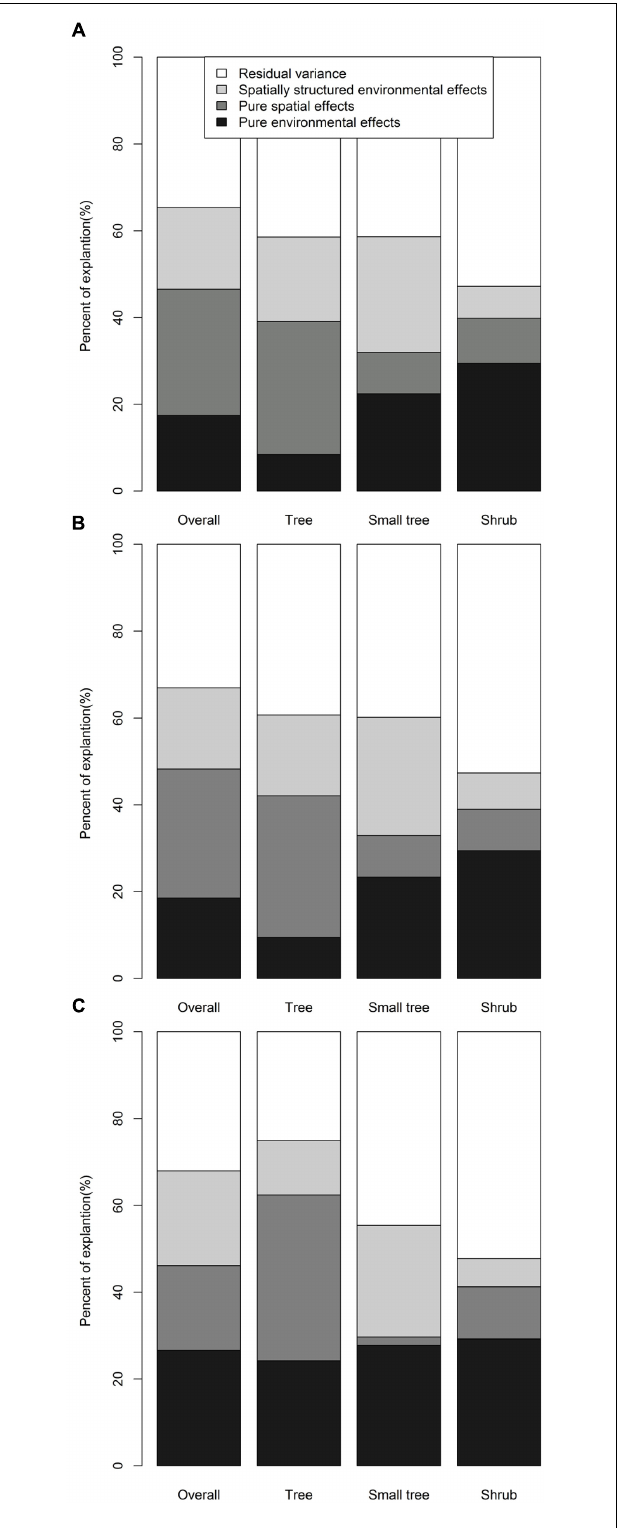
FIGURE 6 | Partial regression analyses for the effects of environmental and spatial processes on the (A) β j , (B) β s , and (C) β sim of species